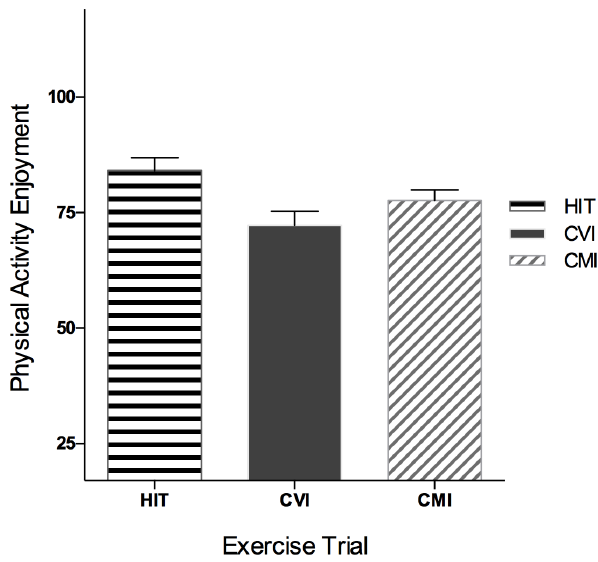
Figure 3. Enjoyment (M ¡ SE) of the three exercise